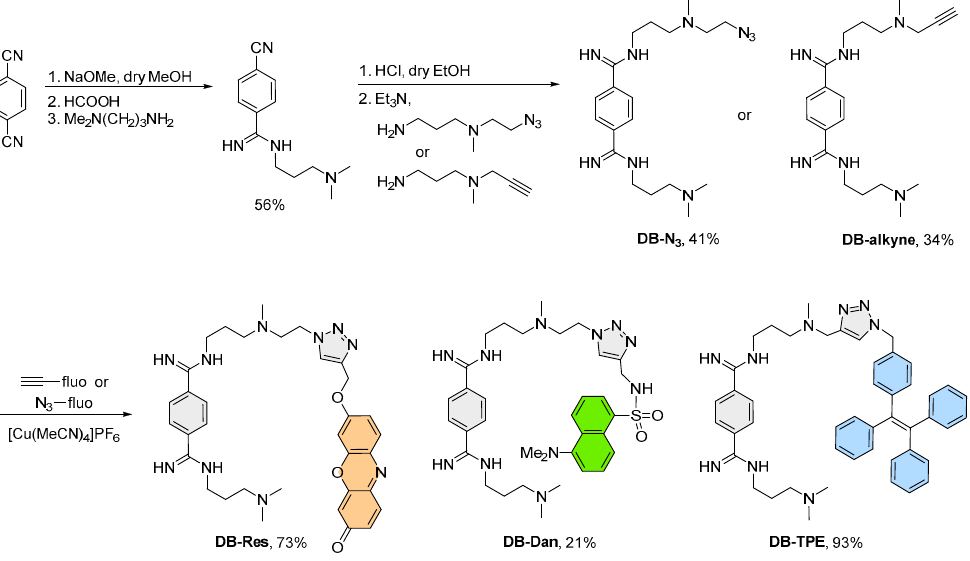
Figure 2. Synthesis of DB-Res , DB-Dan , and DB-TPE .